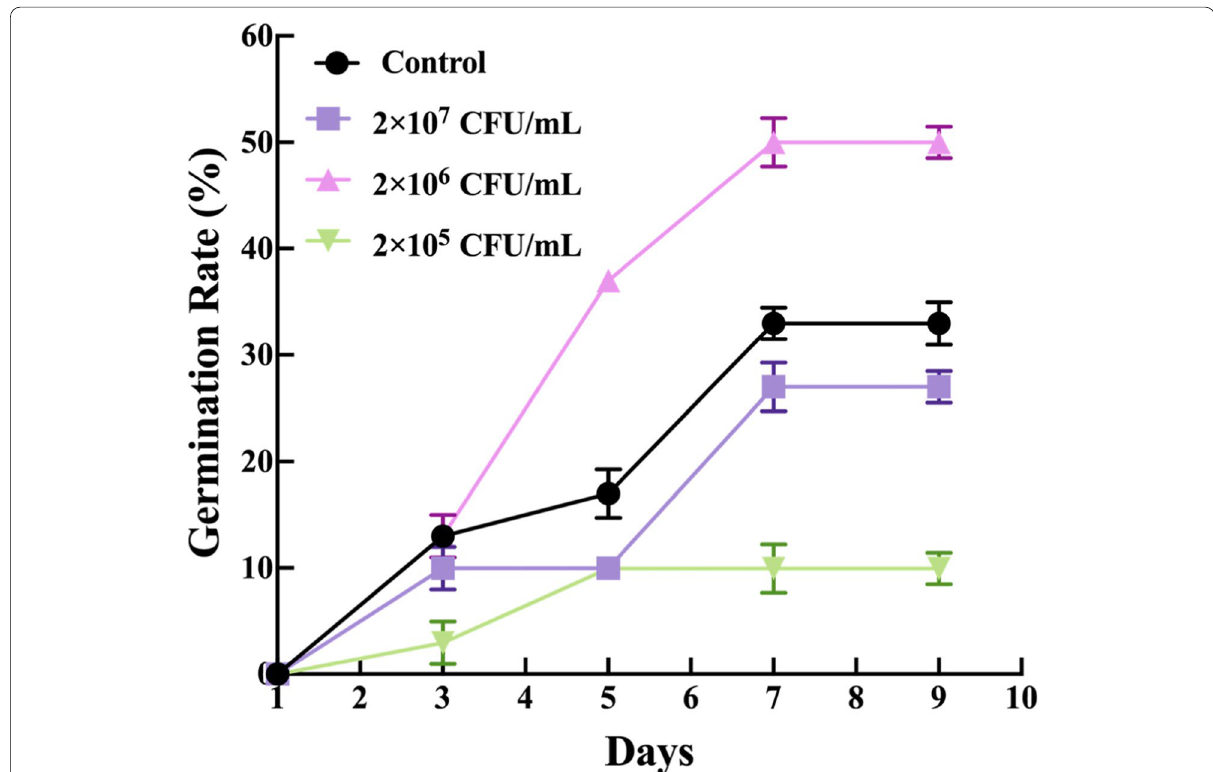
Fig. 4 Seed germination of greengrocery treated with 2 triplicate, and the values are represented as mean concentrations of strains in the same days ( P